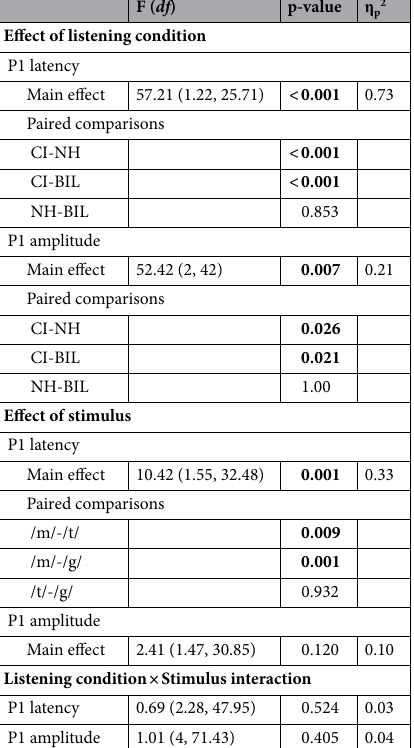
Table 2. Main effects and pairwise comparisons of listening condition, stimulus, and listening condition by stimulus interactions on P1 latency and amplitude. Post-hoc analysis included Sidak’s multiple-comparisons